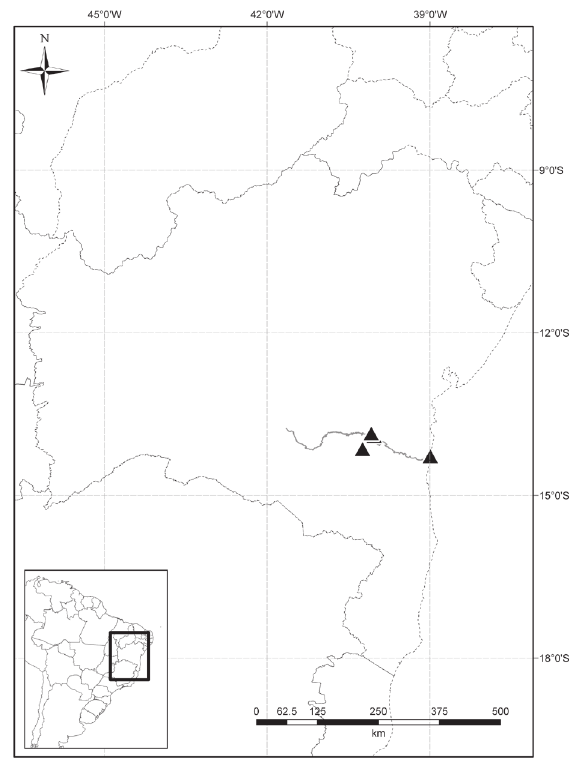
Figure 3. Known distribution of S. evolvuloides Giacomin & Stehmann (triangles) along Rio de Contas (in grey) in the state of Bahia,